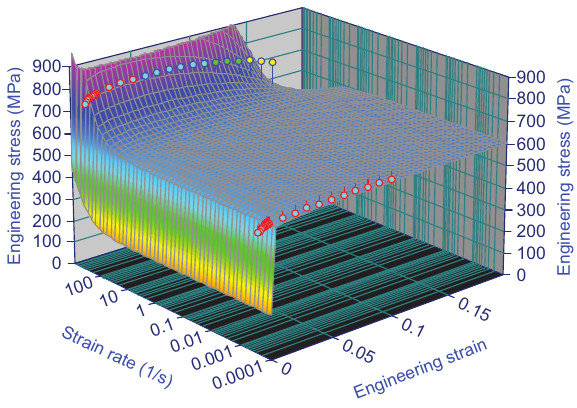
Figure 9 Stress-strain diagram for a wide range of strain rates at a temperature of 295 K.